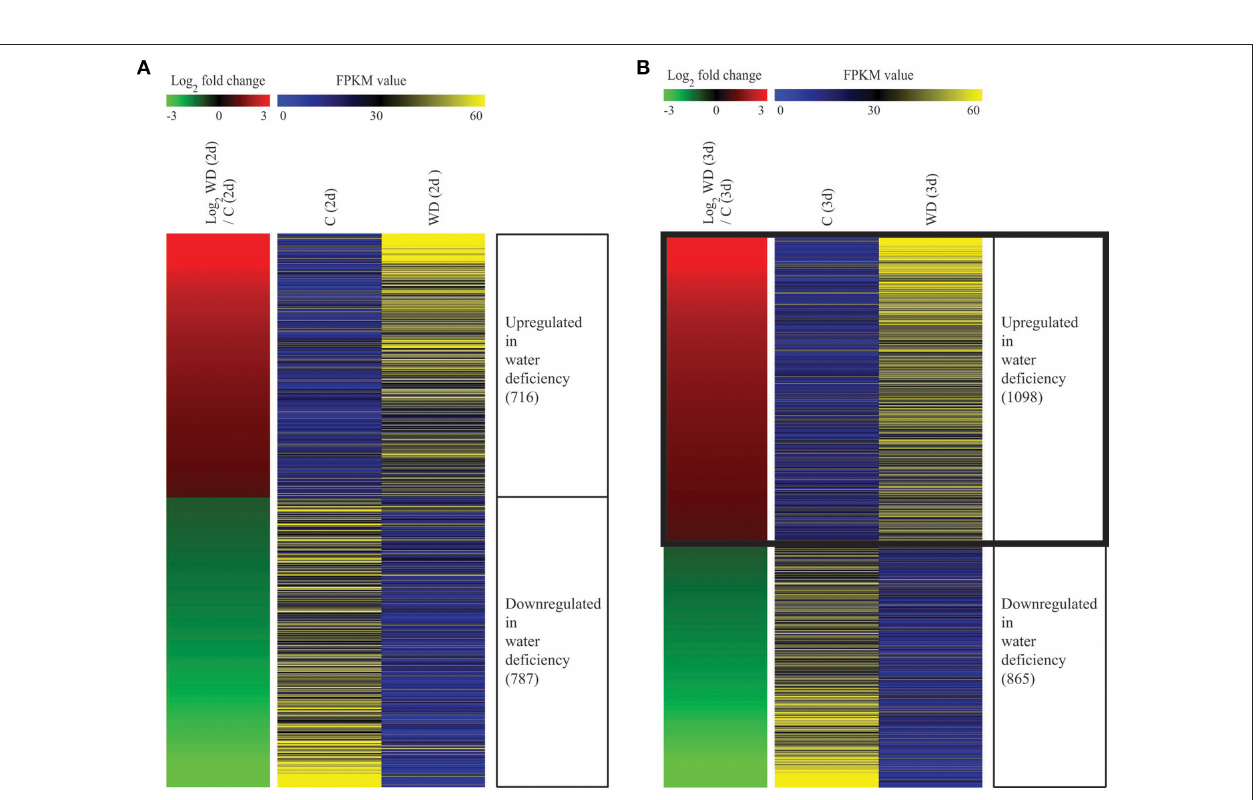
FIGURE 3 | Heatmap of differentially expressed genes under drought stress. Using RNA-Seq data processing under criteria of FPKM > 4, p < 0.05, and ratio of < –1.0 for 1 < log 2 roots exposed to water deficiency (WD) vs. mock-treated rice roots (Control, C), we identified 1,503 differentially expressed genes (DEGs) after 2 d of drought treatment (A) and 1,963 DEGs after 3 d of treatment (B) . In left panel, red color indicates upregulation in WD/C comparison; green, downregulation in WD/C comparison. Right panel shows average normalized FPKM values from RNA-Seq experiments; blue indicates lowest expression level and yellow, highest level. Detailed data about RNA-Seq analysis are presented in Tables S3 , S4